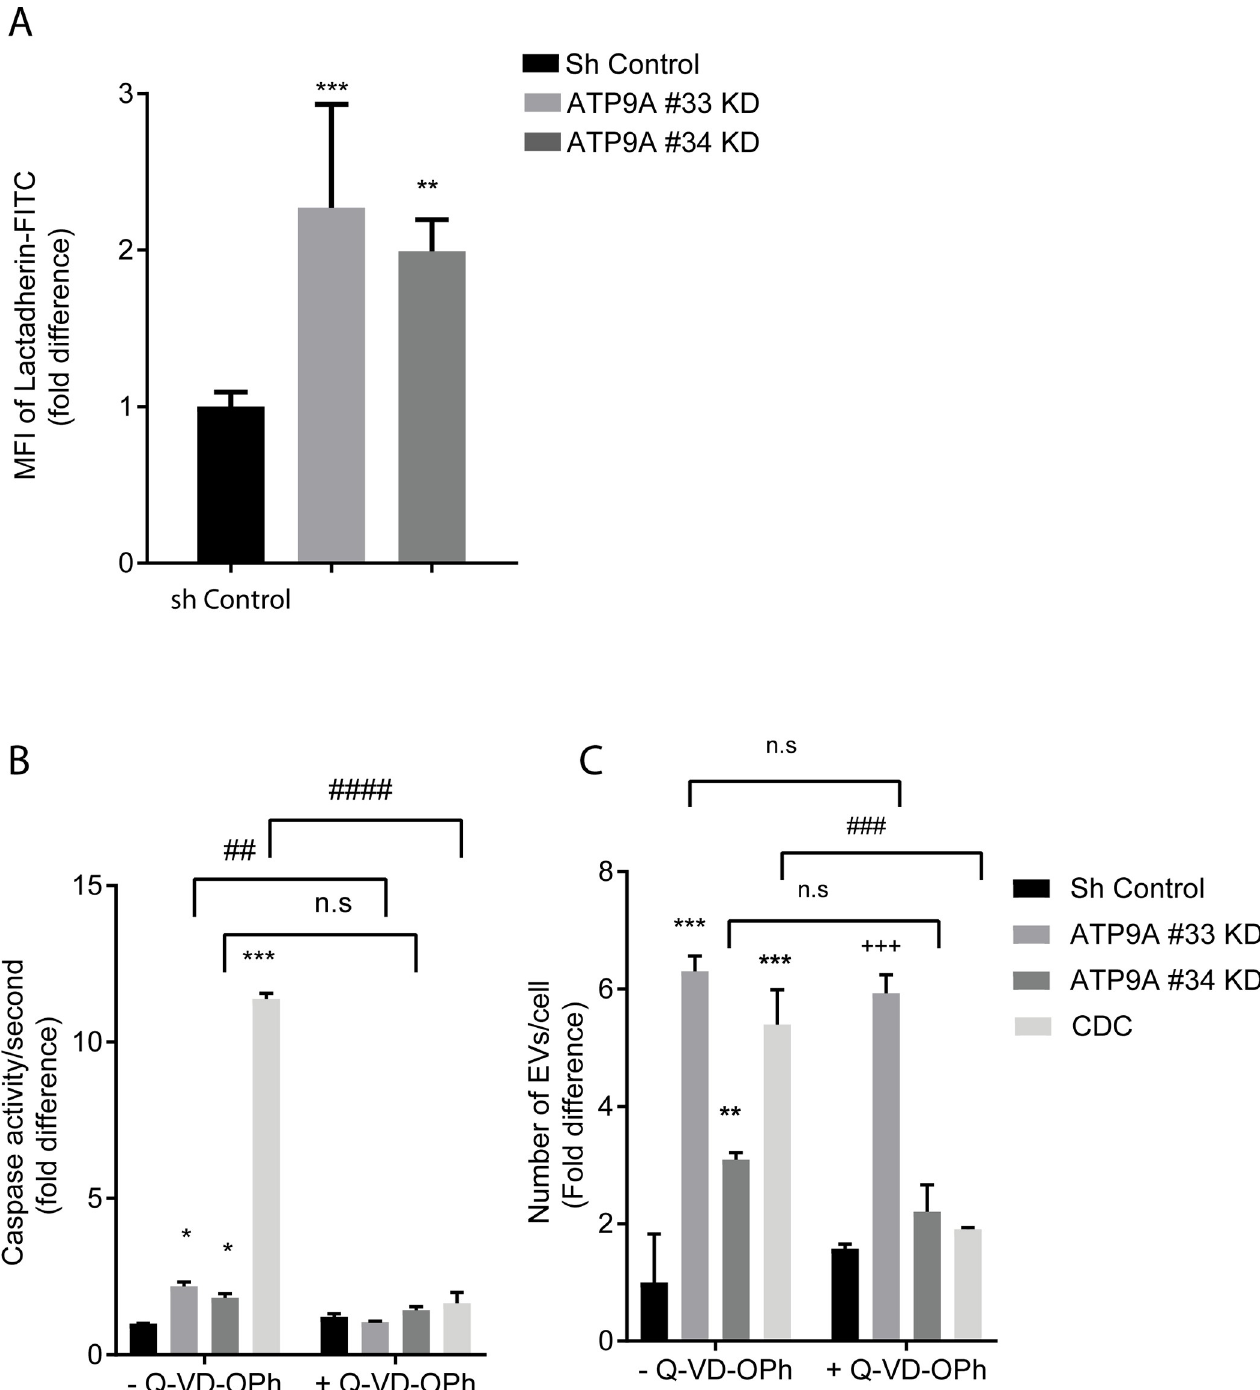
Fig 2. Enhanced EV release in ATP9A knock-down cells is independent of caspase-3 activation. (A) 116 hours after transduction, sh control and ATP9A knock-down cells were incubated with lactadherin-FITC and binding was analysed by FACS. Mean fluorescent intensity (MFI) of ATP9A knock-down cells compared to sh-control cells of two independent experiments performed in six replicates (n = 12) is presented. Statistical significance was tested by one-way ANOVA with Dunnett’s correction for multiple testing: �� p < 0.005, ��� p < 0.0005. (B) Caspase activity in ATP9A knock-down and Chenodeoxycholate (CDC) treated cells compared to sh-control cells in presence and absence of caspase inhibitor. Approximately 48 hours after transduction, sh-control and ATP9A knock-down cells were incubated with or without 5 μ M caspase inhibitor (Q-VD-Oph) and 66 hours later caspase activity was determined. CDC was added as a positive control for apoptosis 1 hour before harvesting cells. (C) Number of EVs/cell in medium of ATP9A knock-down cells and CDC treated cells compared